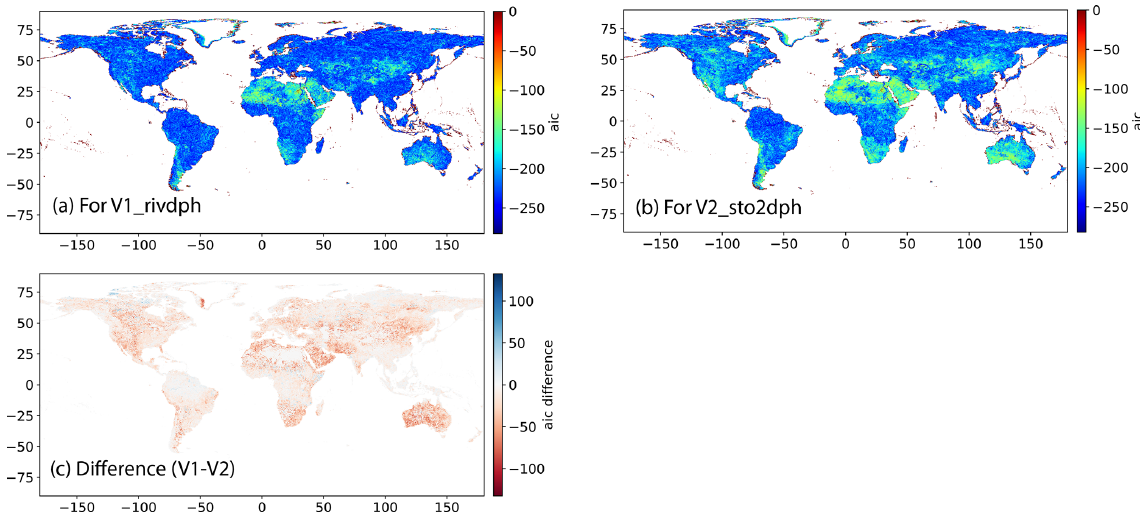
Figure 2. Fitting performance of FFA for (a) V 1 (river water depth) and (b) V 2 (water storage). The performance was quantified with AIC and (c) is the AIC difference of (a) and (b) . This is only an example for the e2o_ecmwf and GEV fitting distribution.